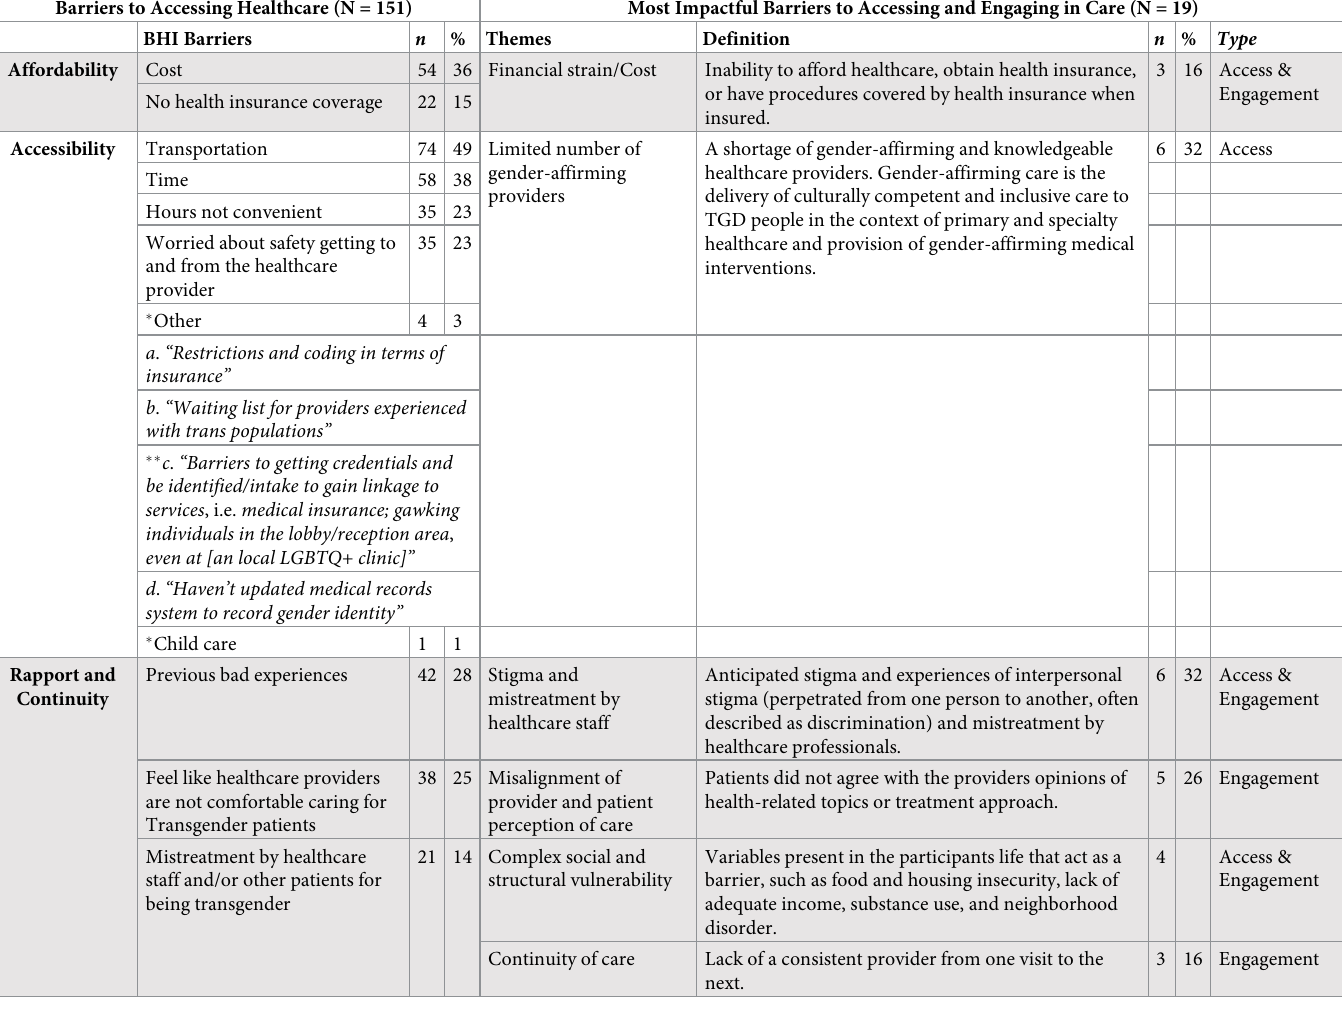
Table 2. Barriers to accessing and engaging in healthcare: Joint display of quantitative and qualitative data. Barriers to Accessing Healthcare (N =